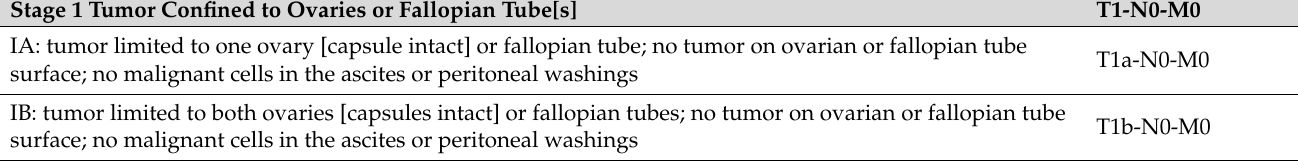
Table 2. FIGO staging of carcinoma of the ovary, fallopian tubes and peritoneum